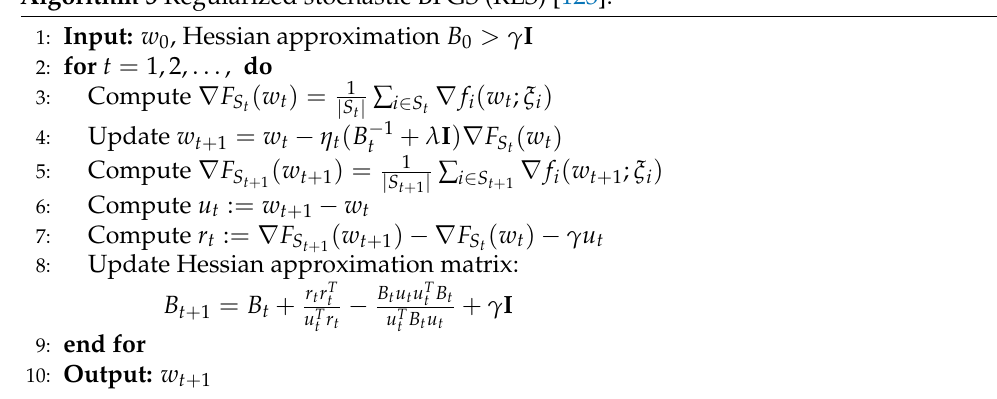
Algorithm 5 Regularized stochastic BFGS (RES)